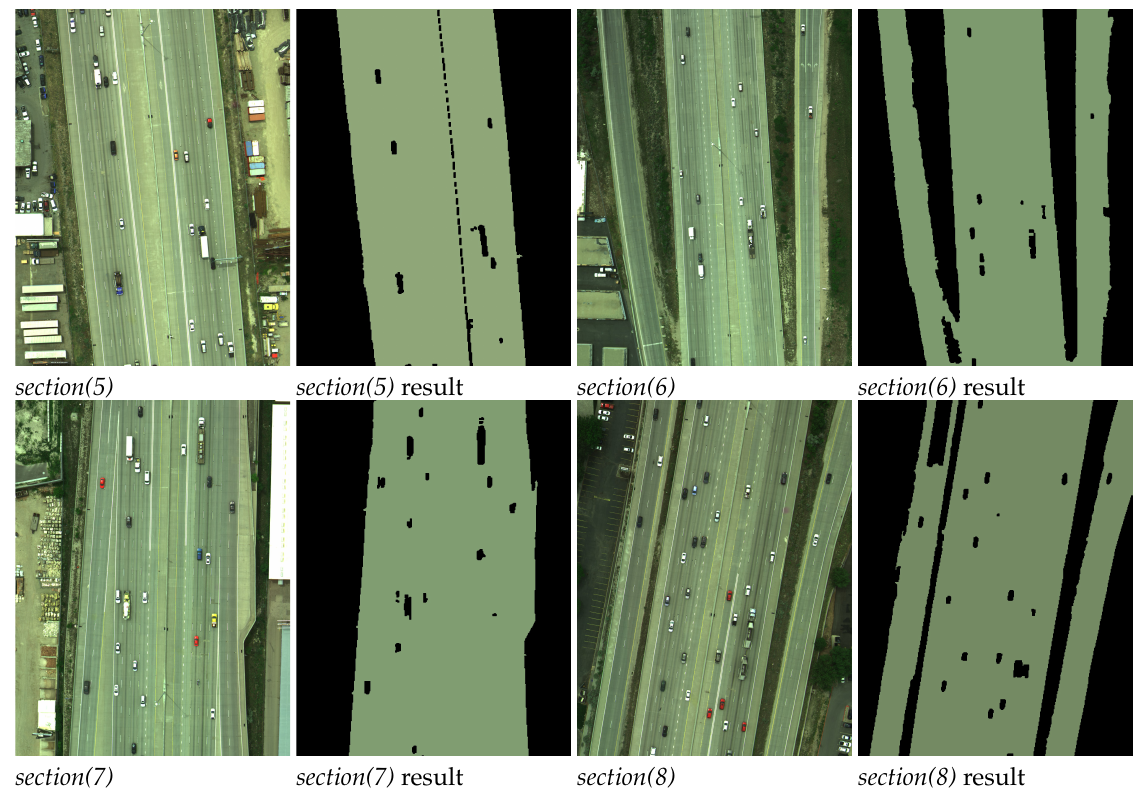
Figure 5. Road extraction results for another four sections of the road, section(5) , section(6) , section(7) , and section(8)